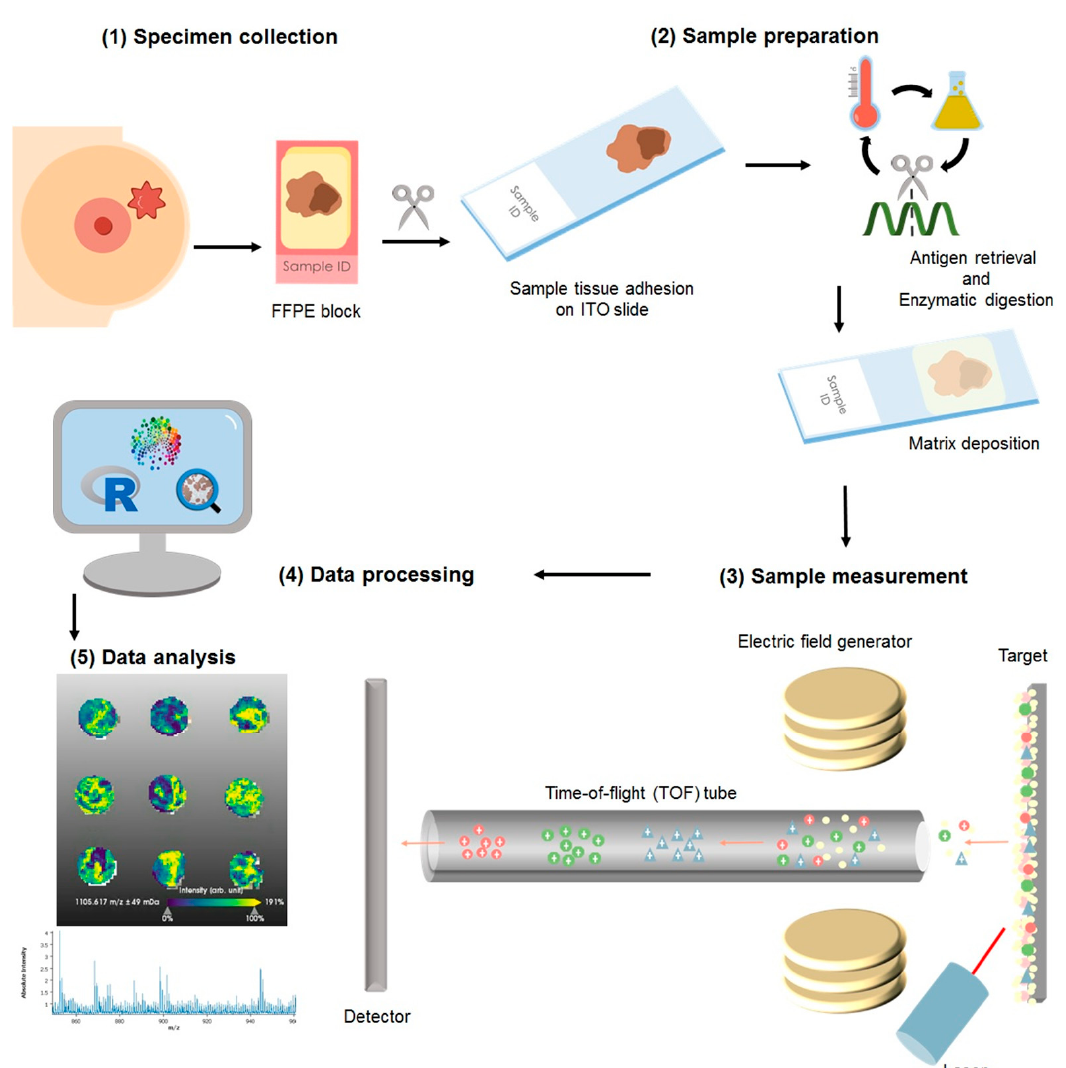
Figure 4. Sample processing for matrix-assisted laser desorption/ionization mass spectrometry im-